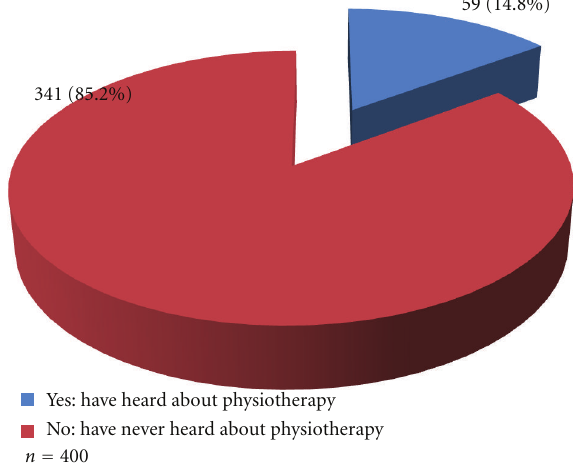
Figure 2: Knowledge of physiotherapy by respondents in the communities.